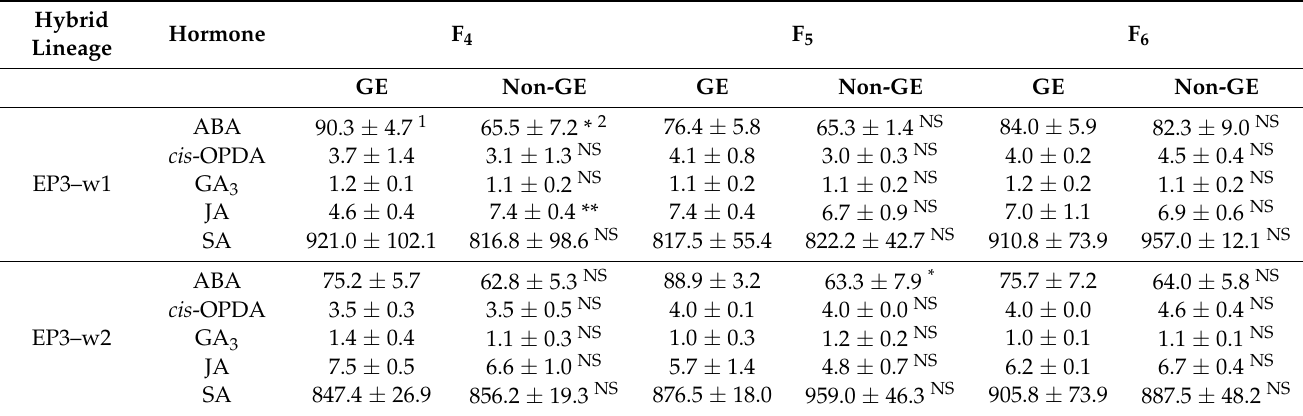
Table 2. Average contents (ng/g) of five plant hormones in genetically engineered (GE) and non-GE F 4 –F 6 dry seeds from hybrid lineages derived from crosses between a GE rice line (EP3) and two wild rice populations (w1 or w2).